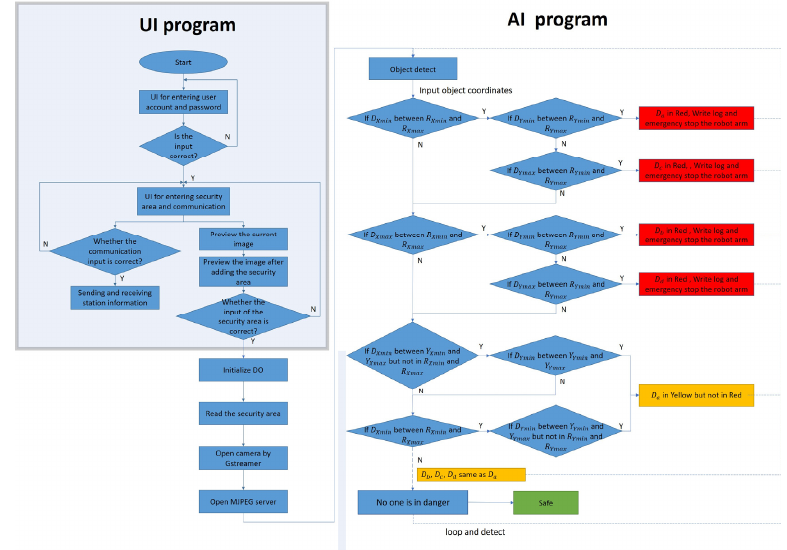
Figure 9. The operation process of robotic arm working-area warning system.